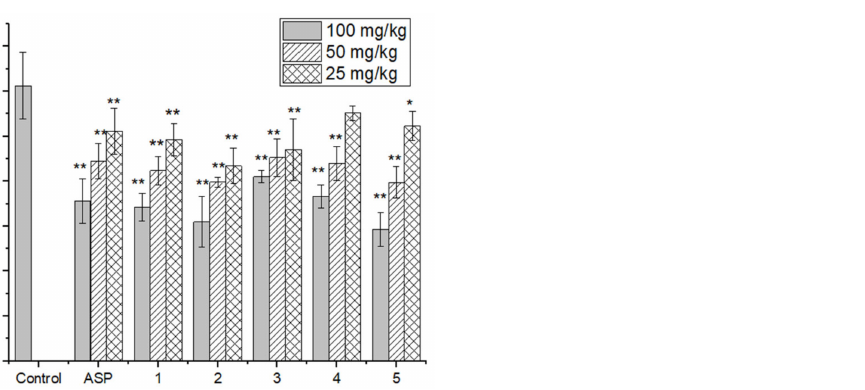
Figure 6. The bioactivity of 1-methylhydantoin cinnamic imides on the swelling degree of xylene- induced ear edema in mice with aspirin as the positive control. The experiment was carried out using high, medium, and low dosages of five compounds. (n = 6, * p < 0.05, ** p < 0.01 vs.